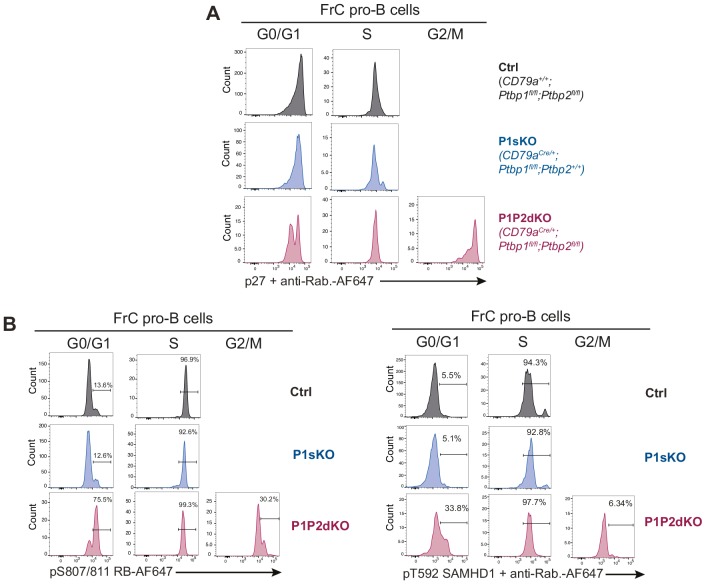
PTBP1 controls CDK activity in FrC pro-B cells.Intracellular staining for p27 (A), pT592-SAMHD1 and pS807/S811-RB (B) amongst FrC pro-B cells. FrC pro-B cells in distinct phases of the cell cycle were identified as shown in Figure 6—figure supplement 1A. Data shown are from one representative mouse out of four or five per genotype. No data are shown for G2/M FrC pro-B cells from control and P1sKO mice as the number of events in these gates was smaller than 100 events.